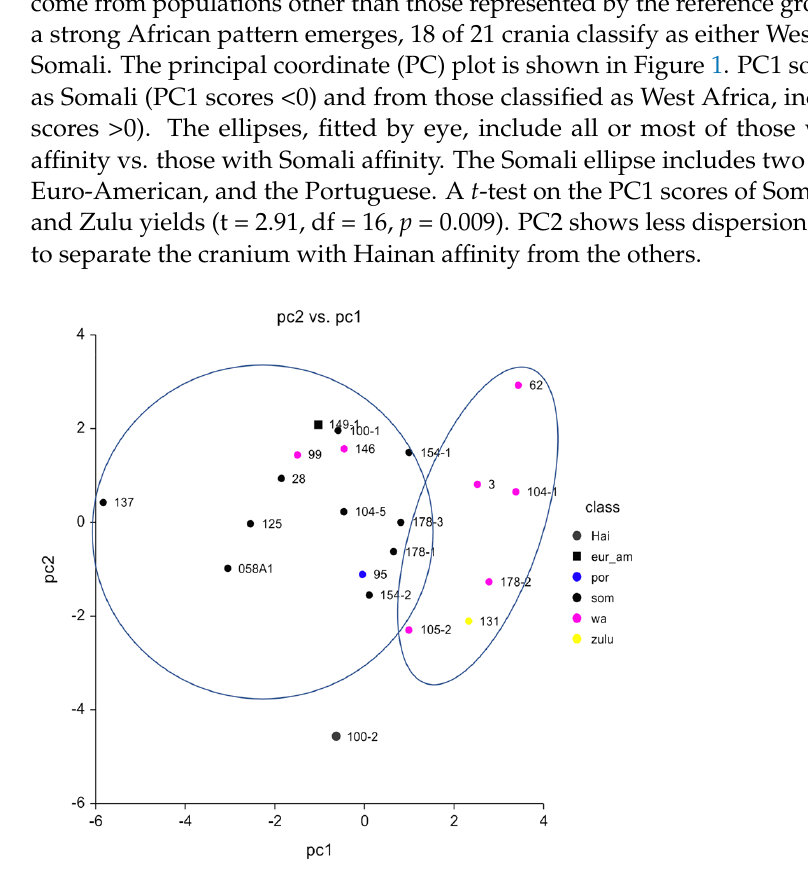
Figure 1. Principal coordinate (PC) plot of the craniometric analyses for ancestry estimation. The ellipses, fitted by eye, include the clusters closer to West Africa (right) and to Somali (left).